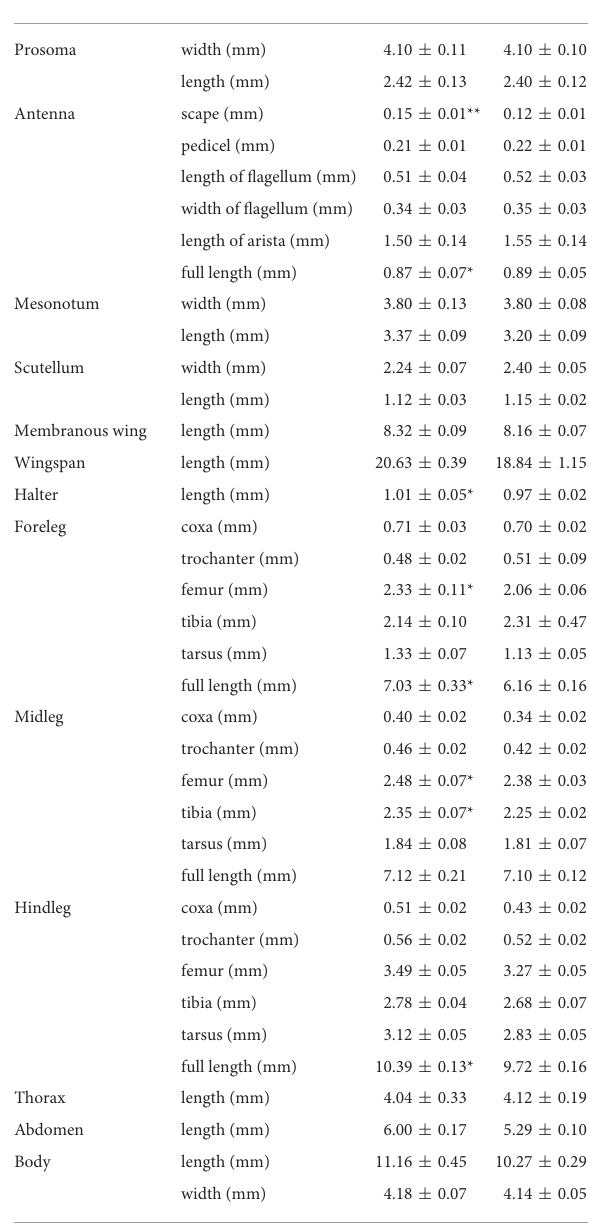
TABLE 1 The adult morphological data of Eristalinus arvorum .